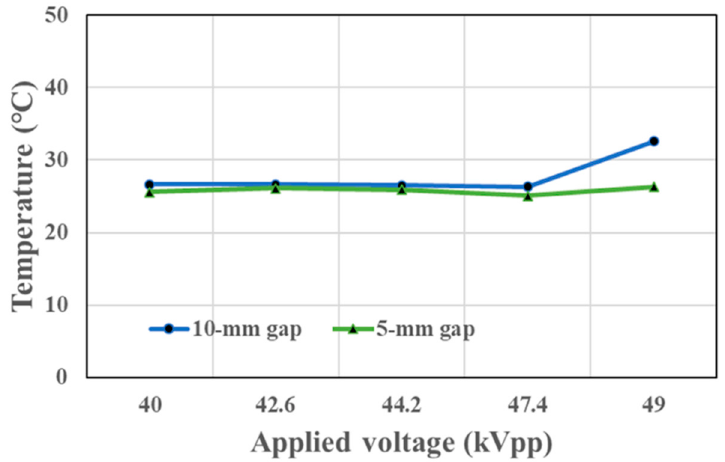
Figure 8. Floor surface monitored by infrared thermometer. The measured maximum temperatures are plotted based on the dependence of the applied voltages ranging from 40 kVpp to 49 kVpp. The conditions shown here were 5- and 10 mm electrode gaps without airflow.